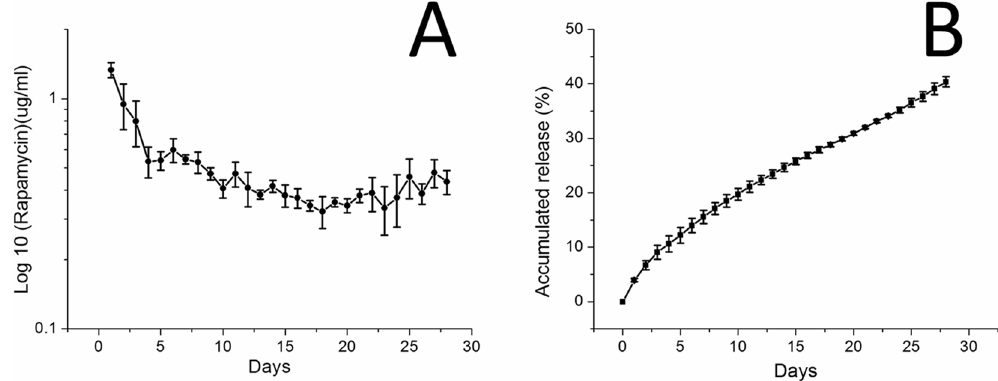
Figure 7. ( A ) Daily and ( B ) accumulated release curves of rapamycin from the biodegradable drug-eluting stents.